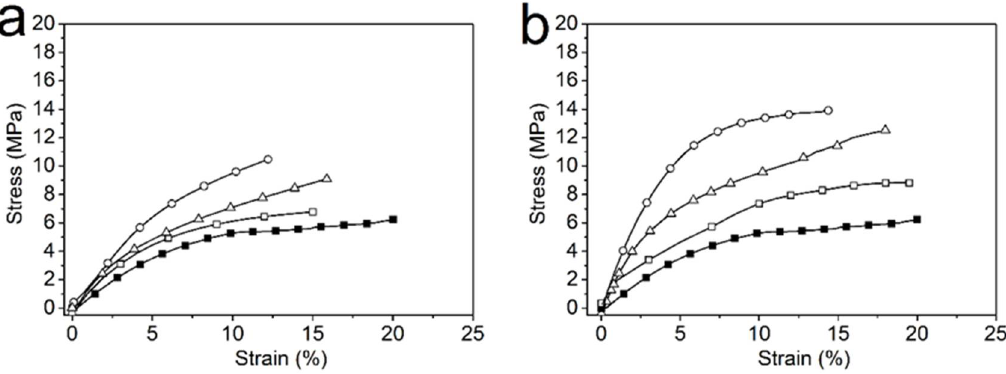
Figure 5. Stress versus strain curves for ( a ) TPS (closed squares), and TPS with GO incorporated at 0.5 mass% (squares), 1.0 mass% (triangles) and 2.0 mass% (circles) contents; ( b ) TPS (full squares), TPS with rGO incorporated at 0.5 mass% (squares), 1.0 mass% (triangles) and 2.0 mass% (circles) contents.